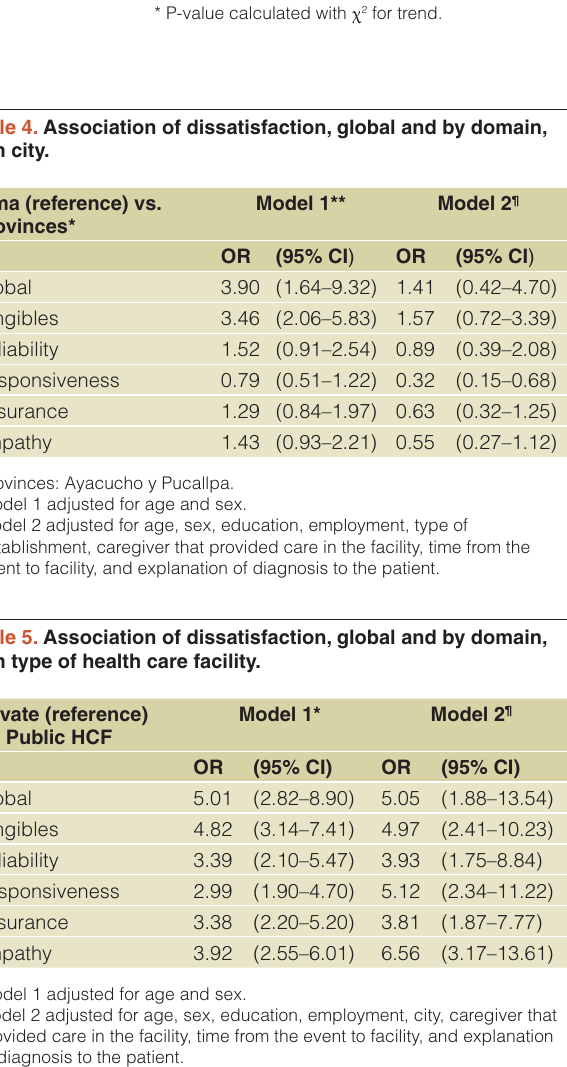
* P-value calculated with χ 2 for trend.